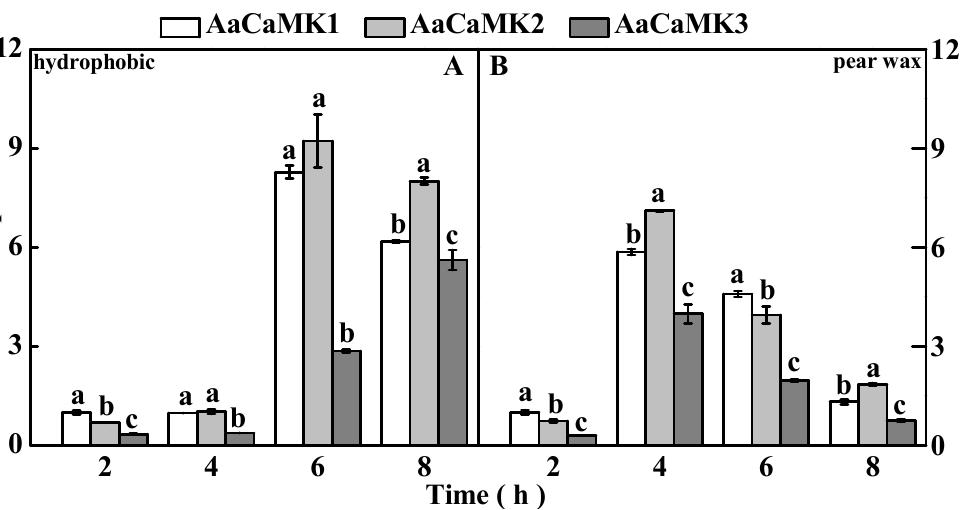
Figure 5. Relative expression levels of AaCaMKs during the infection structure differentiation stage of A. alternata on hydrophobic ( A ) and pear wax ( B ) substrates by qRT-PCR. Vertical lines indicate the standard error (±SE) of the means. Different letters indicate significant differences ( p < 0.05).